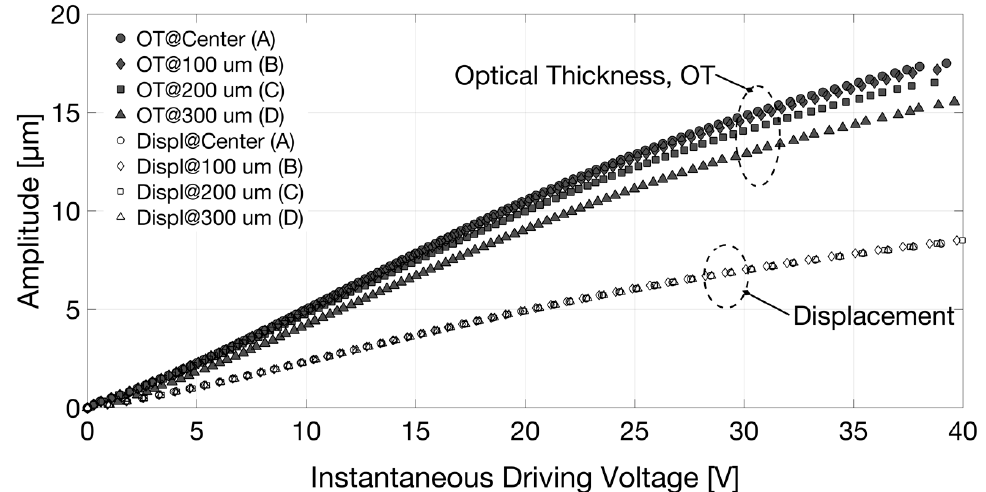
Figure 6. Amplitude of the displacement (Displ) (white filled markers) of the support glass and of the optical thickness (OT) (black filled markers) variations as a function of the instantaneous driving voltage, for dV/dt > 0, in positions A (pupil center), B, C, and D (at increasing distances from the lens pupil center). Circles : results at pupil center (position A). Diamonds : results @100 µm (position B). Squares : results @200 µm (position C). Triangles : results @300 µm (position D).